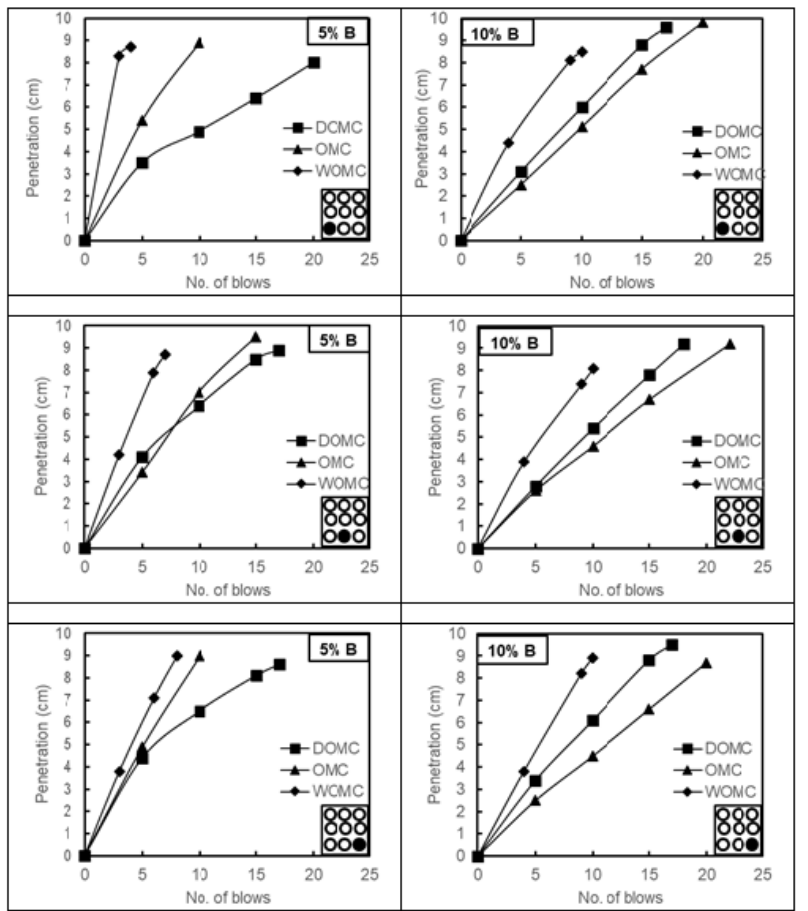
Figure 4. Penetration profiles for three points located along the bottom row (1) for 5% and 10% bentonite mixtures .